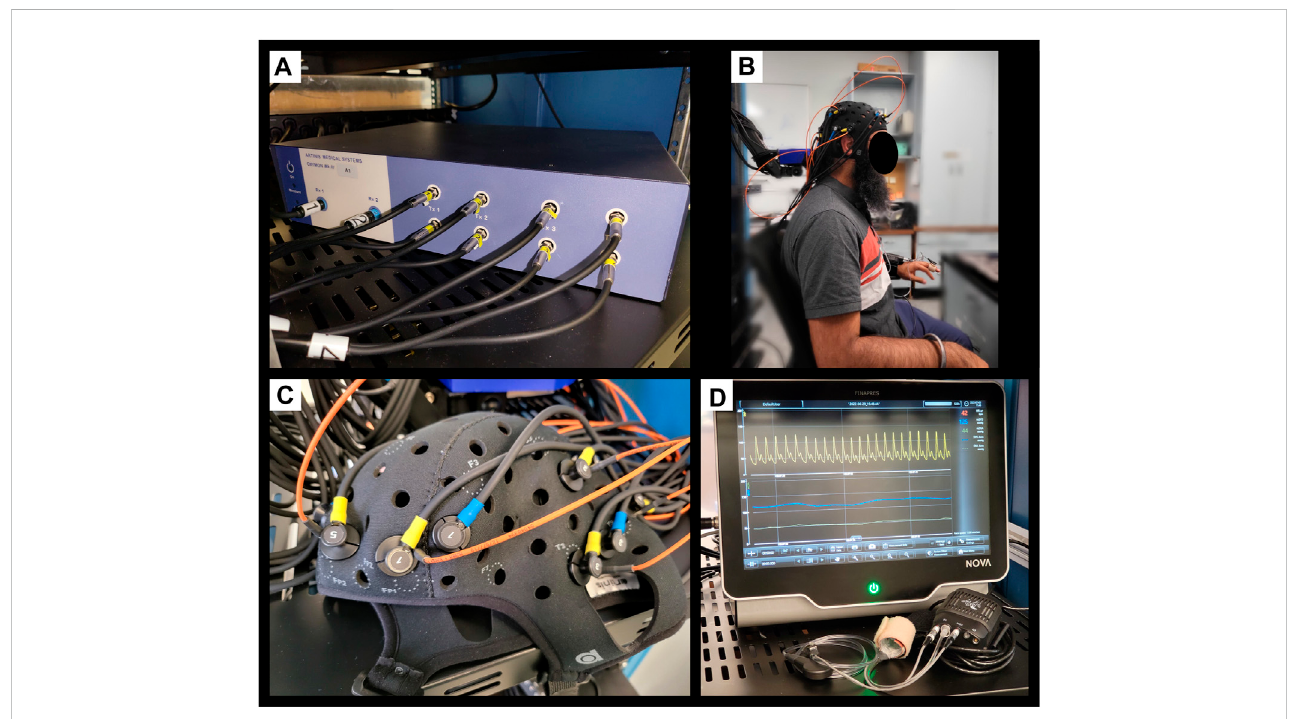
FIGURE 2 Conceptual NIRS channel layouts on a human brain template (A) , Conceptual 8 channel setup of NIRS device on a template of the right and left hemispheresofahumanbrain. (B) ,Conceptual24channelgridsetupofNIRSdeviceonthelefthemisphereofahumanbrain.Ch,channel;NIRS,near-infrared spectroscopy; Rx, receiver; Tx, transmitter. Note — grid layouts are entirely customizable for evaluating one or all regions of the brain with the required optodes, with the given rectangular grid in panel B provided as just an